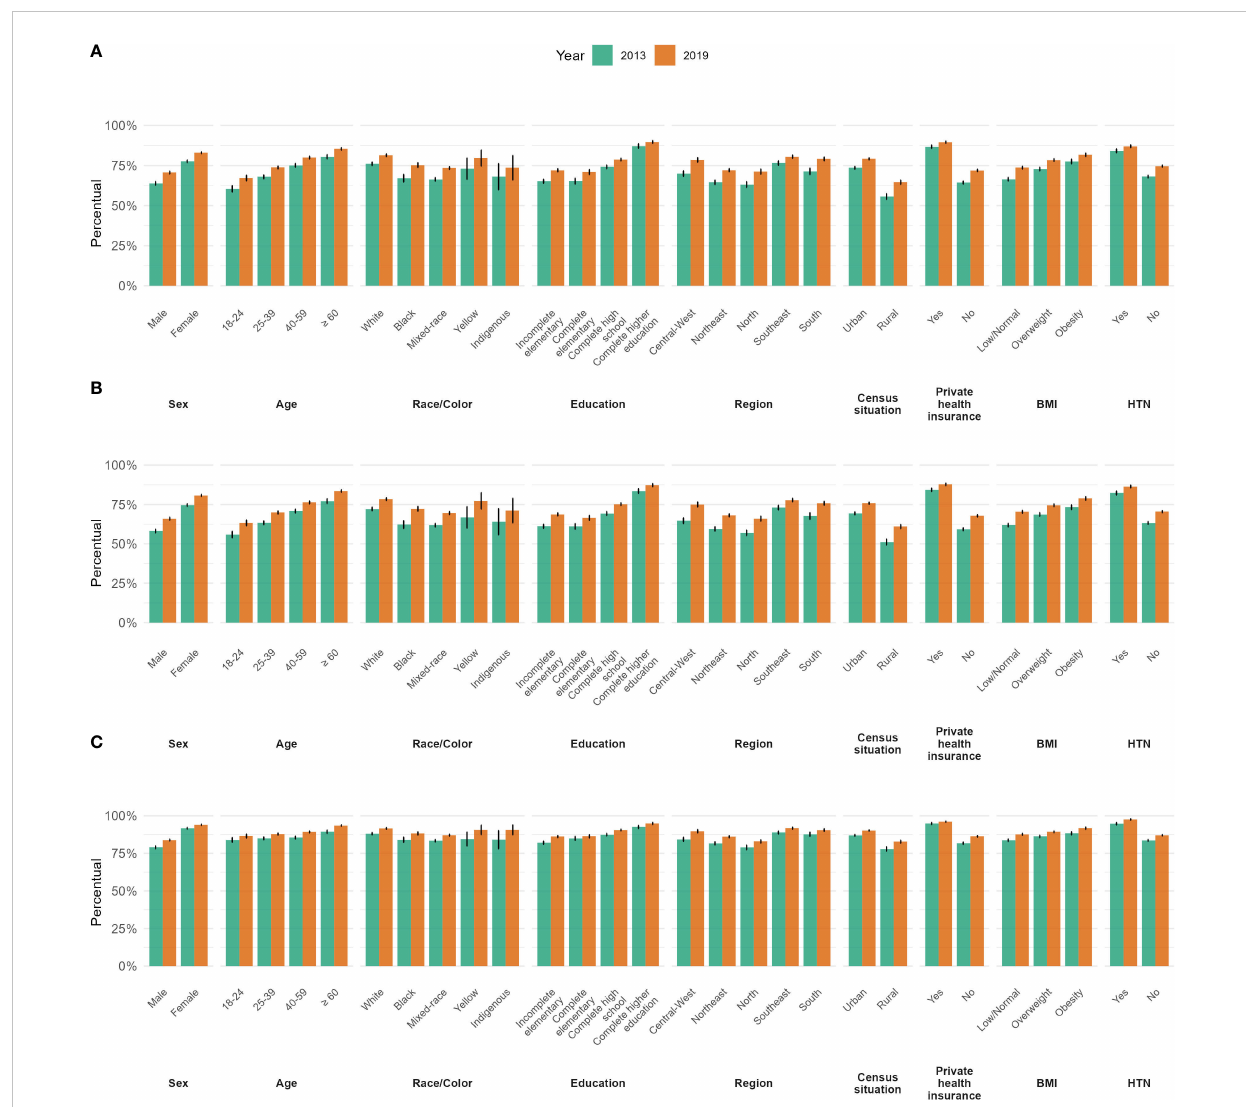
FIGURE 2 Frequency of recent (over the previous 2 years) access to a diagnosis of diabetes by sociodemographic and clinical characteristics considering three options to de fi ne access: (A) Glucose test, (B) Glucose and medical consultation, (C) Medical consultation, Brazilian National Health Survey, 2013 and 2019. BMI, Body mass index; HTN,